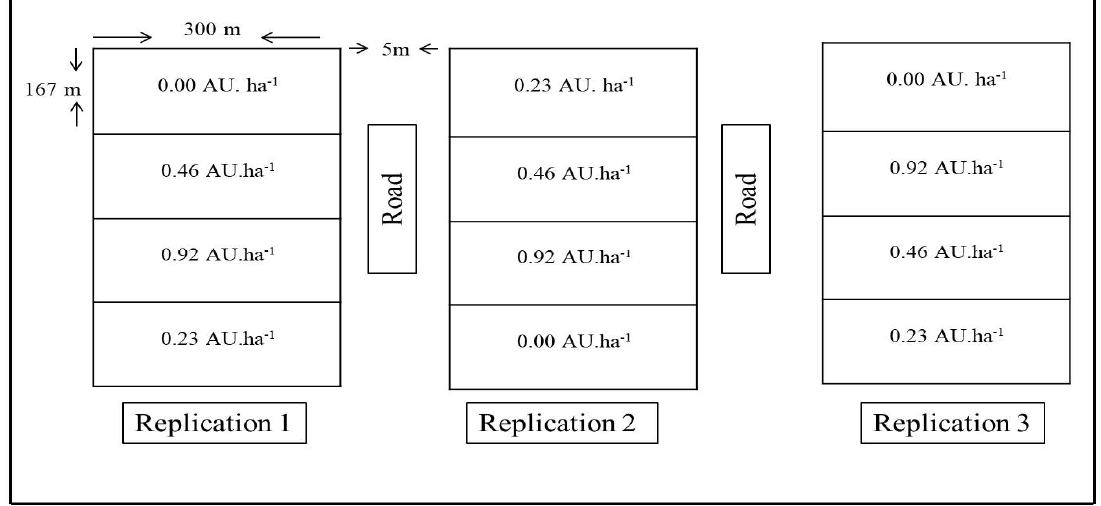
Figure A1. Experimental design. Values 0.00, 0.23, 0.46 and 0.92 AU ha −1 correspond to the no grazing (CK), light grazing (LG), moderate grazing (MG) and heavy grazing (HG) treatments, respectively (where 1 AU = 500 kg of adult cattle). We achieved the stocking rates used. 0, 2, 4 or 8 young cattle (250–300 kg) per plot [74]. Agronomy 2020 , 10 , x FOR PEER REVIEW